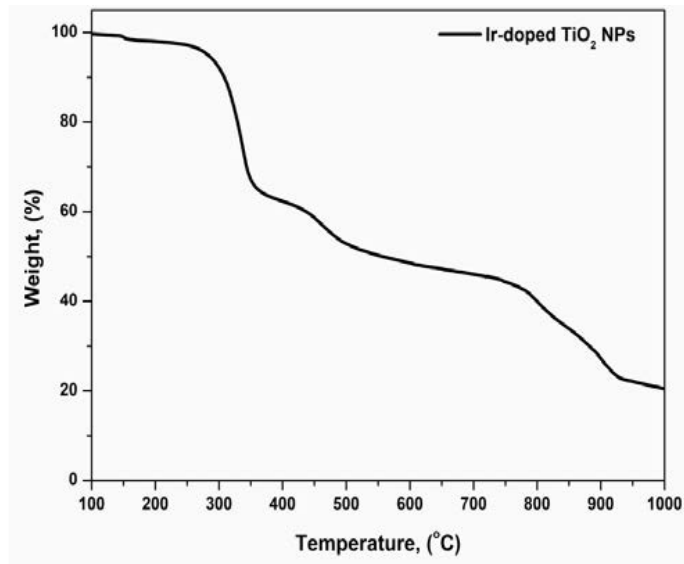
Fig. 7: Thermogram of Ir-doped TiO